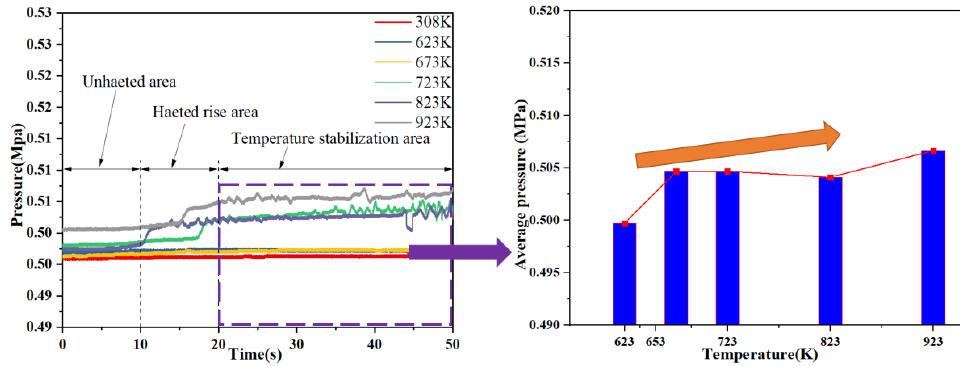
Figure 7. Upstream pressure fluctuation curve of capillary.